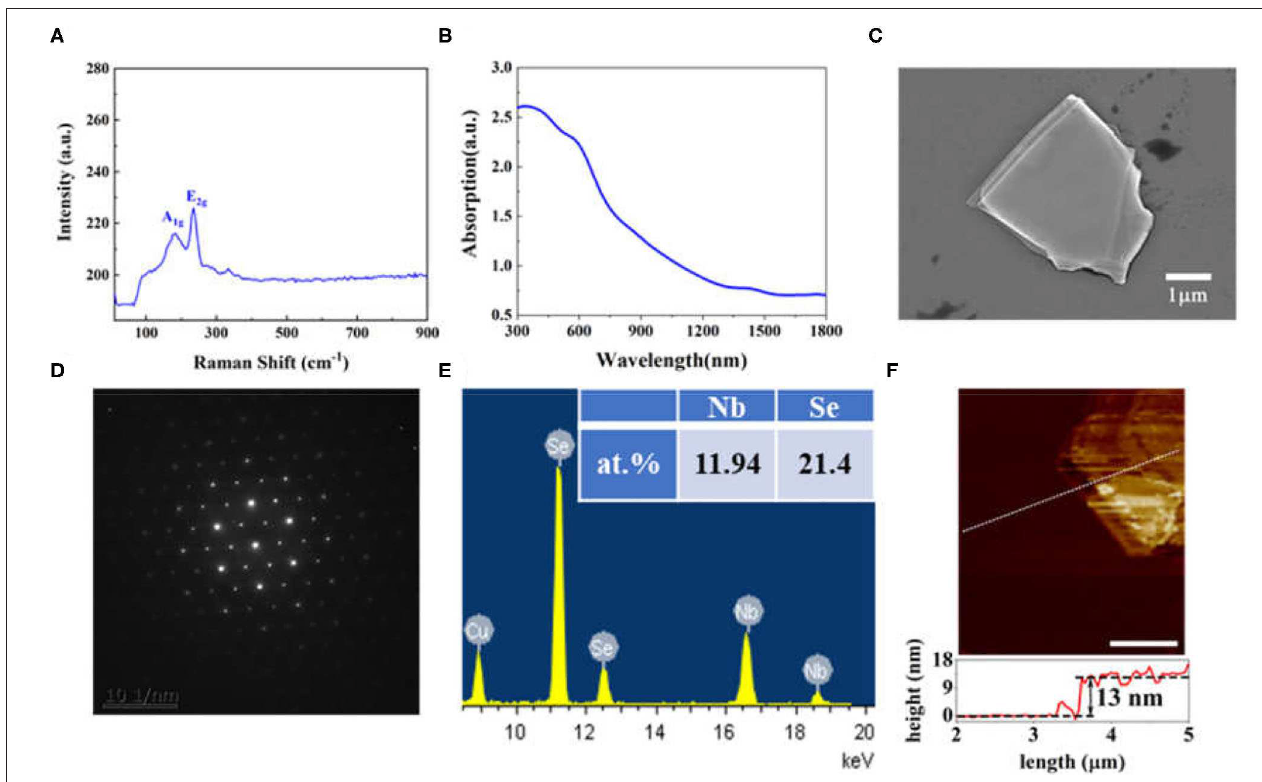
FIGURE 1 | The characterizations of the few-layer NbSe 2 . (A) Raman spectroscopy. (B) Linear absorption spectrum. (C) SEM image. (D) SAED image. (E) EDS energy spectrum (the atomic percentages of Nb and Se are illustrated in the upper right corner). (F) AFM